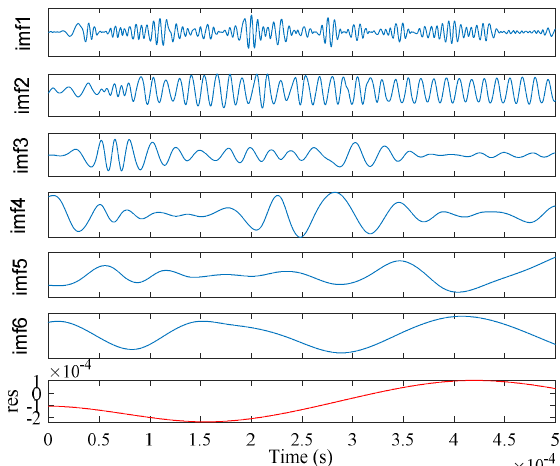
Figure 9. Intrinsic Mode Functions (IMF) of the preprocessed signal. Appl. Sci. 2018 , 8 , x FOR PEER REVIEW